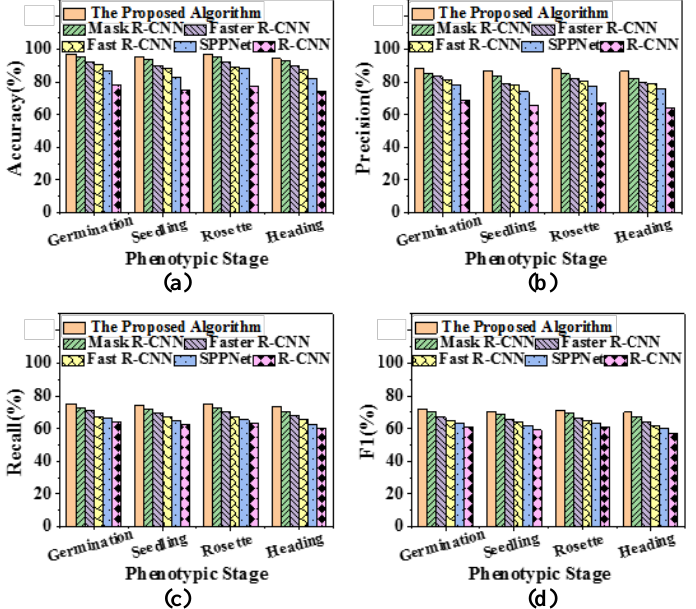
Figure 7. Recognition accuracy map of each phenotypic stage of plants under different algorithms ( a ) accuracy; ( b ) precision; ( c ) recall; ( d ) F1.